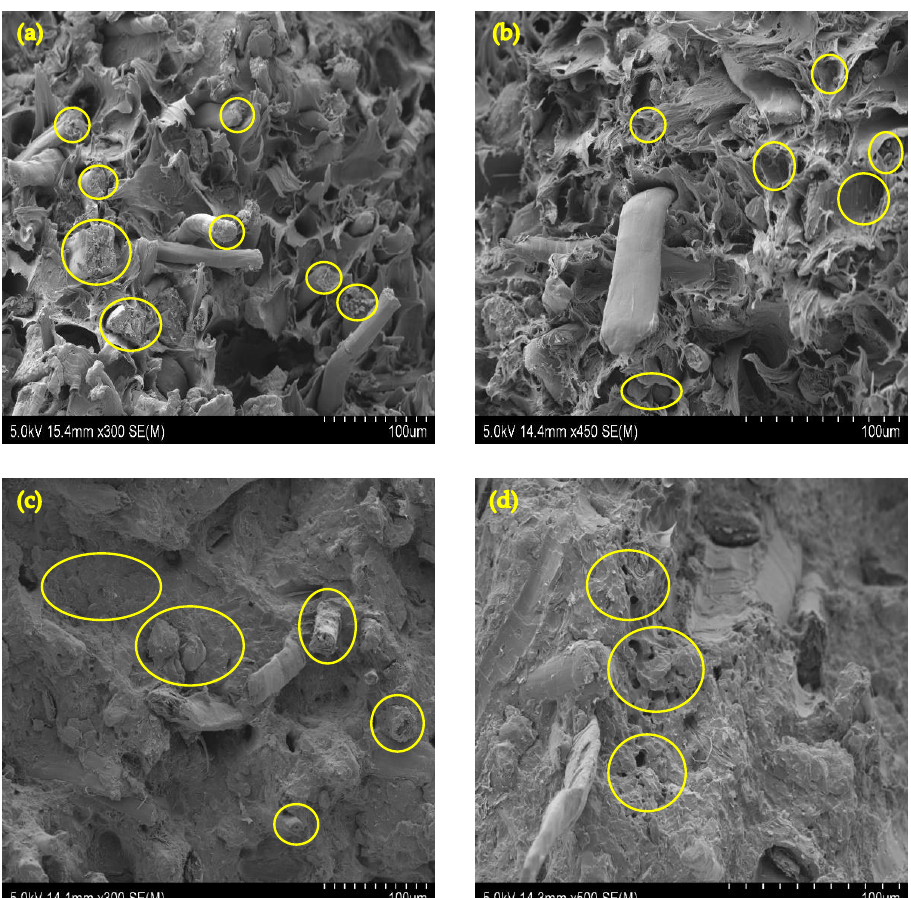
Figure 3. SEM images of tensile fractured surface of various types of composites: ( a ) F-PP, ( b ) F-PPIFR, ( c ) F-PPIFRG1.0 and ( d ) F-PPIFRG2.0.